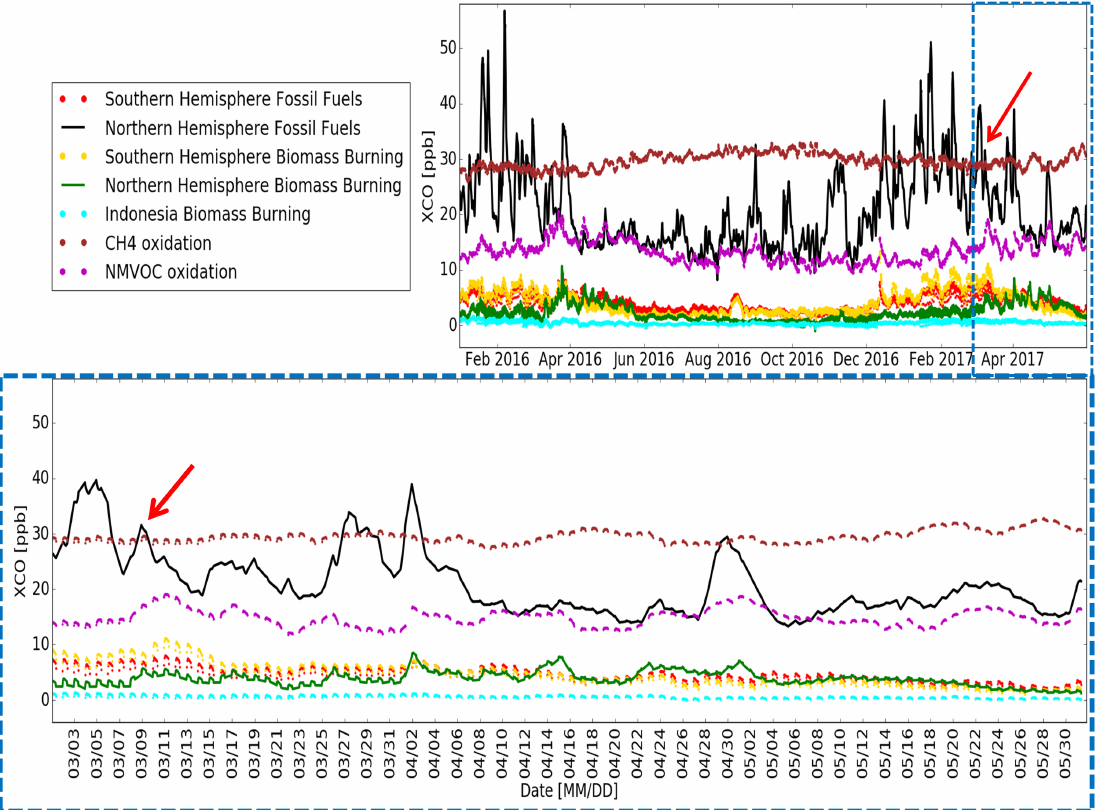
Figure 9. Top right: Tagged tracer simulations of CO from GEOS Chem for January 2016 to May 2017. This plot shows the contribution of different sources to the column averaged dry air mole fractions of CO at the TCCON site in Burgos. The bottom plot shows a zoom-in on March–May 2017. The inundation in the X CO is dominated by the fossil fuel signals (“Northern Hemisphere Fossil Fuels”, black line), which are mostly from East Asia (Figure 8), especially on 9 March (indicated by the red arrow). The background contributions from CH 4 and NMVOC oxidation are significant but the enhancements are much less. The biomass burning signals from South America, Africa and Indonesia around March contribute little in this